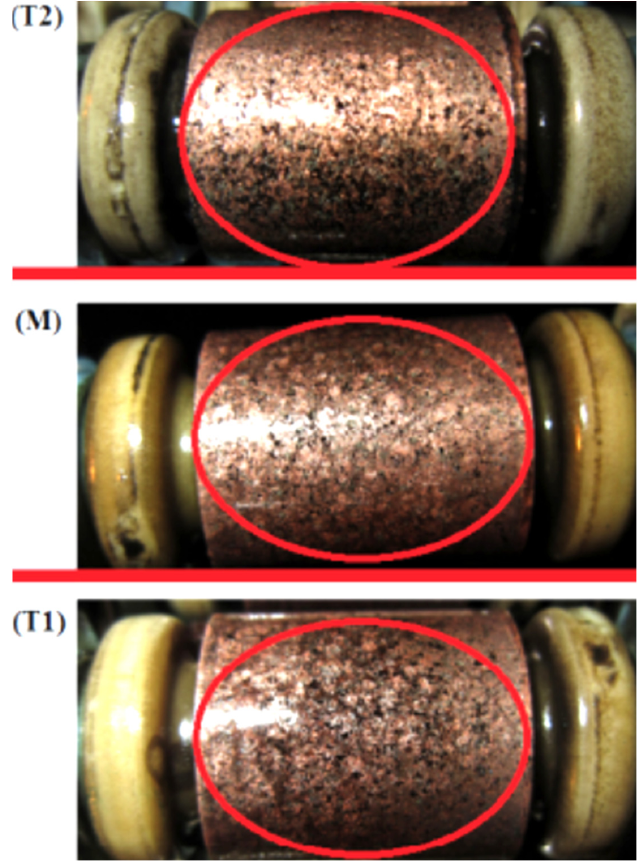
Figure 9. Erosion marks at the OLTC’s main transition contact (M1) and two other transition contacts (T1 and T2) for the red phase [19].